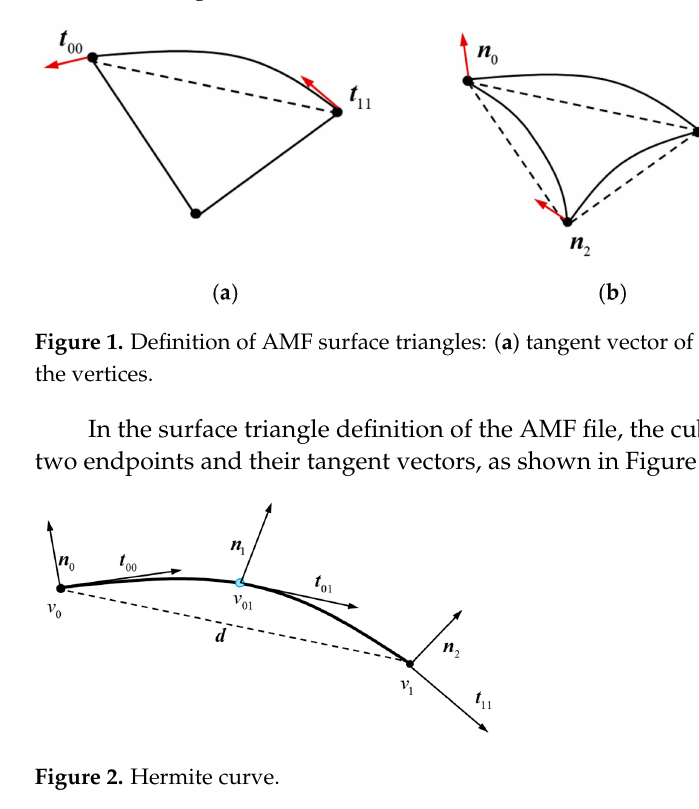
( c ) Figure 3 . Curved triangle parameters: ( a ) parameters of each side; ( b ) curved triangle; ( c ) mapping of parameter fi elds. The shape of the Hermite surface triangle is in fl uenced by the location of its vertices, the direction of the tangent vectors, and the size of the tangent vectors. Each surface tri- angle has a di ff erent shape, so the shape of the base triangle formed by the three vertices of the surface triangle is also di ff erent. This would introduce too many parameters and increase the computational cost. To facilitate the calculation, the a ffi ne transformation is